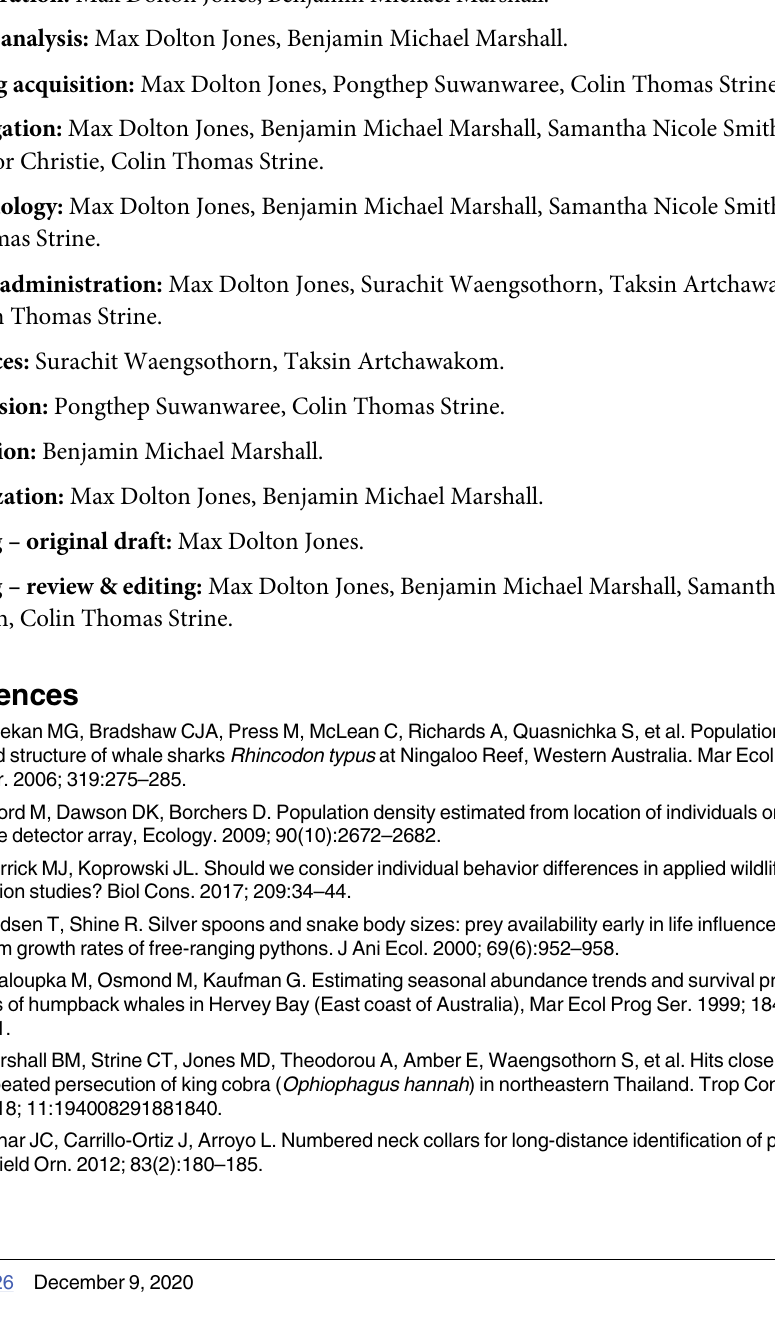
S1 Fig. Zooniverse workflow example. A preliminary design for the subcaudal scale arrange- ment project workflow as seen by Zooniverse volunteers. S1 File. Simulated Bayesian logistic regression